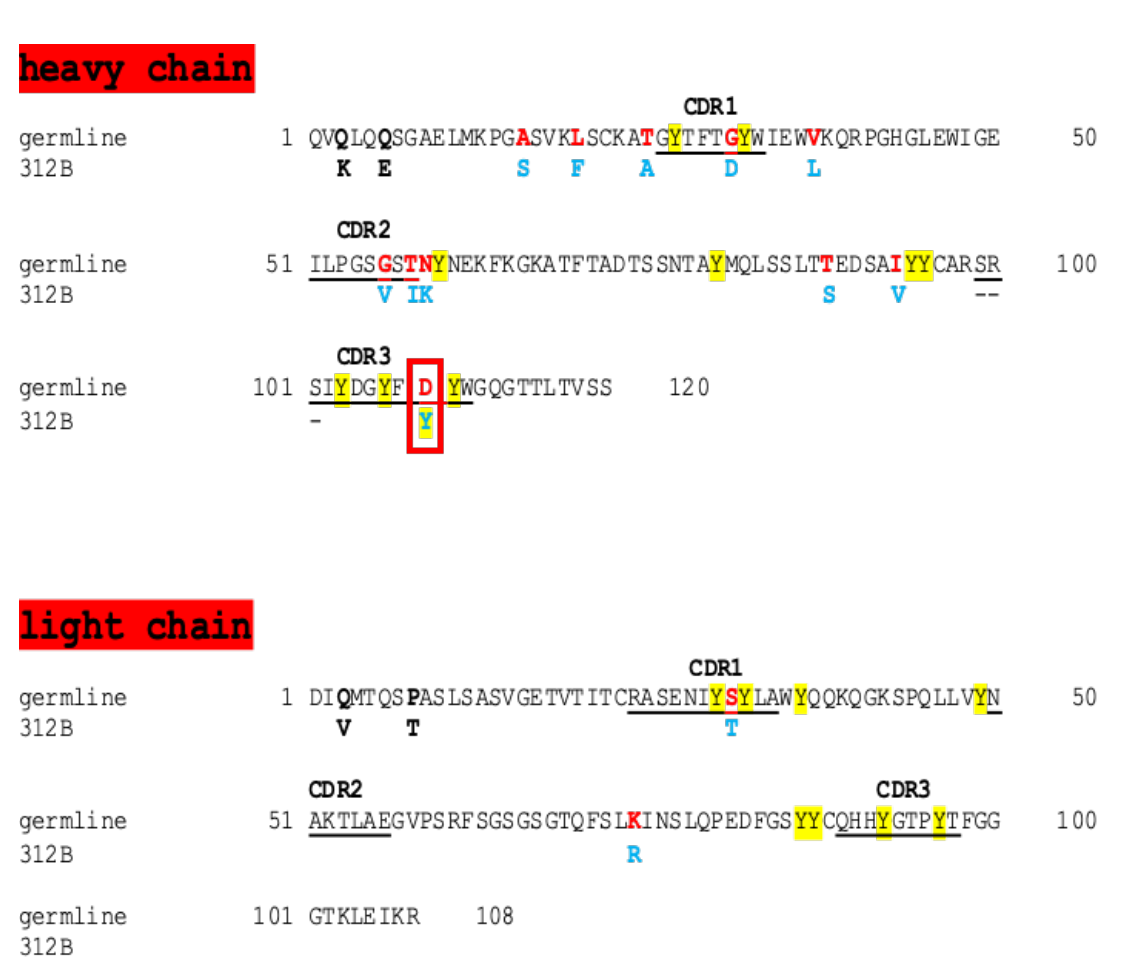
Figure 2. Comparison of the primary V H and V L aa sequence of the anti-La mab 312B with its germline sequence. The aa mutated in the germline sequence by somatic hypermutation (SHM) are labeled in red and those replaced by the aa are labeled in blue for the mature, murine 312B V H and V L aa sequences. The aa given in bold are most likely caused by the degenerated PCR primers used for amplification of the V H and V L domains. The CDRs are underlined. All tyrosine residues are highlighted in yellow. Red box: the only tyrosine residue which is not encoded by the germline sequence is caused by a SHM leading to replacement of the aspartate residue. Dashed line in the CDR3 region: during recombination of the V H gene, N-nucleotides were inserted between the V and the DJ gene elements. The inserted N-nucleotides encode the aa SRS in the CDR3 region of the V H domain.